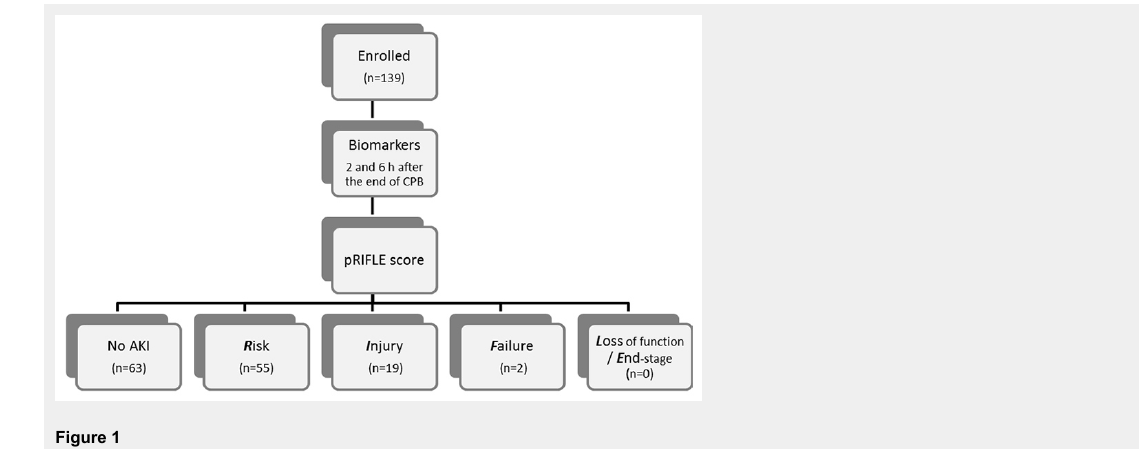
Flow diagram of the study.